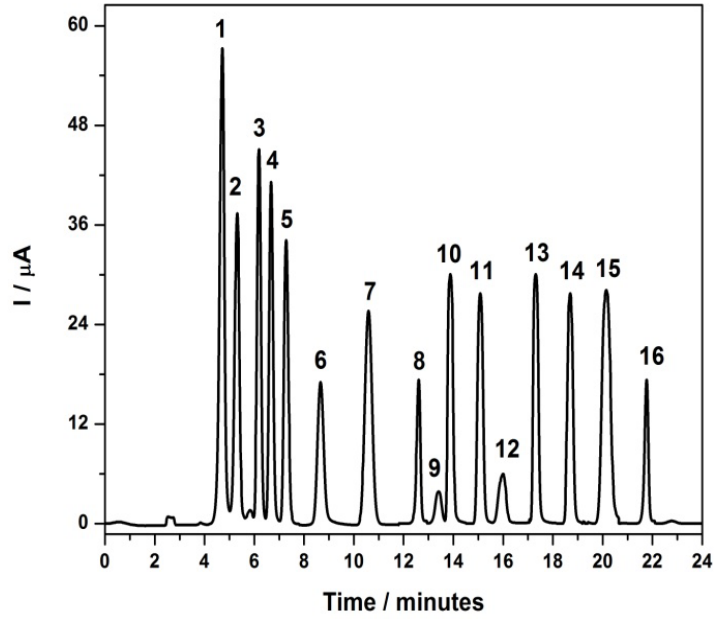
Figure 6. HPLC/ED chromatograms obtained for 20 mL of standard solution of 24 mg·L − 1 of the selected amines. Mobile phase: MeOH/water +30 mM BMIm[NTf ] 70:30 (v/v); T: 2 40 °C, flow-rate: 0.80 mL·min − 1 ; C phase column, E: +1.00 V. 1 : 18